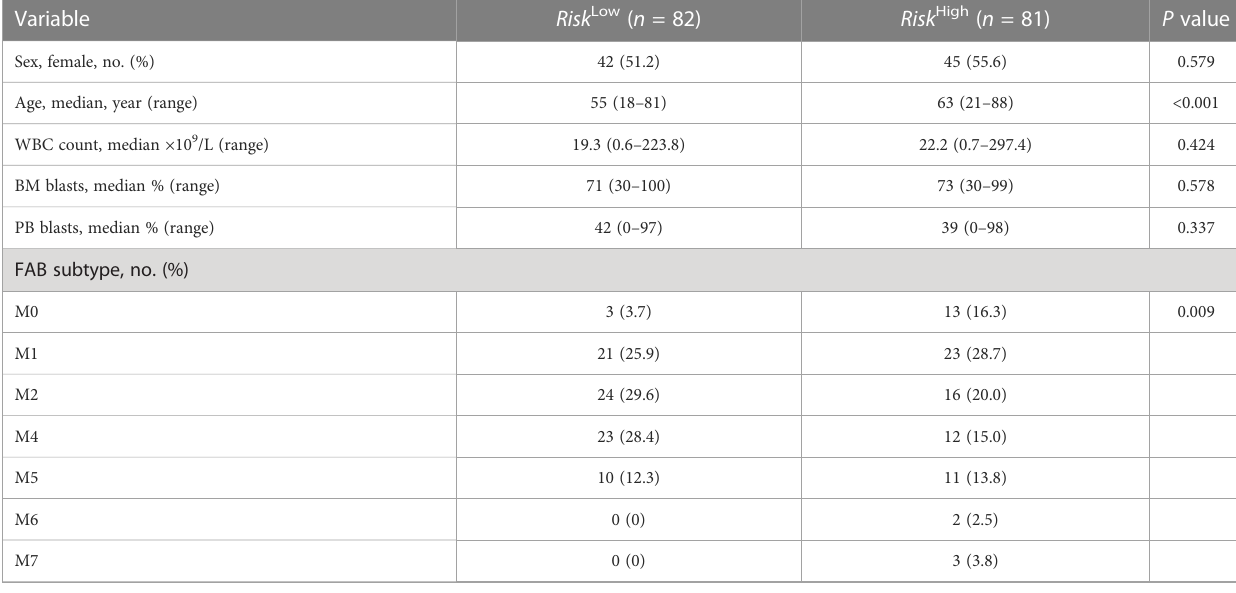
the low-score group, patients in the high-score group were older ( P < group and a low – prognostic score group (Table 1) based on the 0.001). No signi fi cant difference was found in sex, WBC count, ratio of median prognostic score as the cutoff value. Additionally, bone marrow blasts, and FAB classi fi cation between the two groups. corresponding clinical features of those samples that were Also, no signi fi cant difference was observed in chemotherapy and signi fi cantly associated with prognosis were analyzed using Pearson´ transplantation regimens between the two groups (Table 1). The s correlation test or Fisher ’ s precision probability test. Compared with TABLE 1 Clinical and molecular characteristics of patients with AML having high and low risk scores. Variable Risk Low ( n = 82) Risk High ( n = 81) P value Sex, female, no. (%) 42 (51.2) 55 (18 –